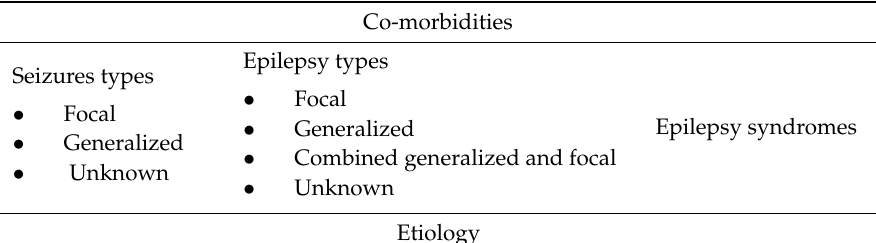
Table 2. Classification of the epilepsies